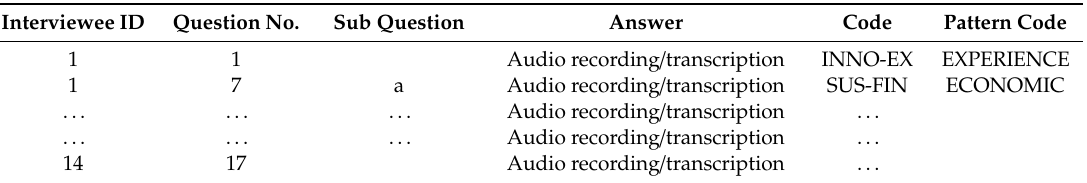
Table 3. Evaluation sheet 2, description of interview results.